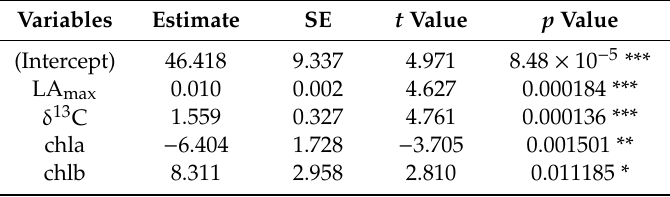
Table 4. The regression coe ffi cients for the multiple linear model of shoot fresh biomass (SFB) as a function of maximum leaf area (LA max ), carbon isotope composition ( δ 13 C), and contents of chlorophyll a (chla) and chlorophyll b (chlb). *: p < 0.05; **: p < 0.01; ***: p < 0.001. Residual standard error: 0.7793 with 19 degrees of freedom (DF). Multiple R 2 = 0.7287, adjusted R 2 = 0.6716. F-statistic: 12.76 with 4 and 19 DF. The multiple linear regression equation for SFB is y = 46.418 + 0.010LA max + 1.559 δ 13 C − 6.404chla + 8.311chlb, p = 3.286 × 10 − 5